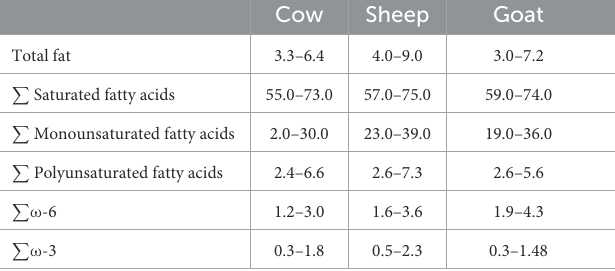
TABLE 3 Milk fat content (g/100g) and main fatty acid groups (% of total fatty acids) in milk from ruminants. Cow Sheep